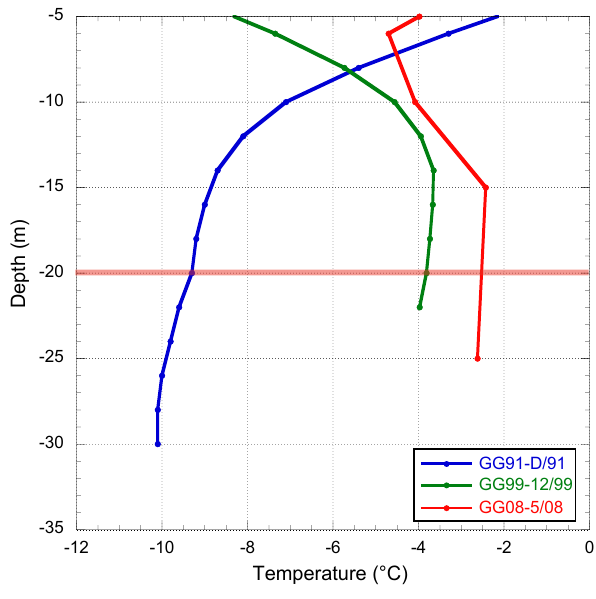
Fig. 9. Temperatures measured in GG91-D/91 (Laternser 1992) and GG99-12/99 (Suter 2002) on Grenzgletscher, compared with the new measurements at GG08-5/08.